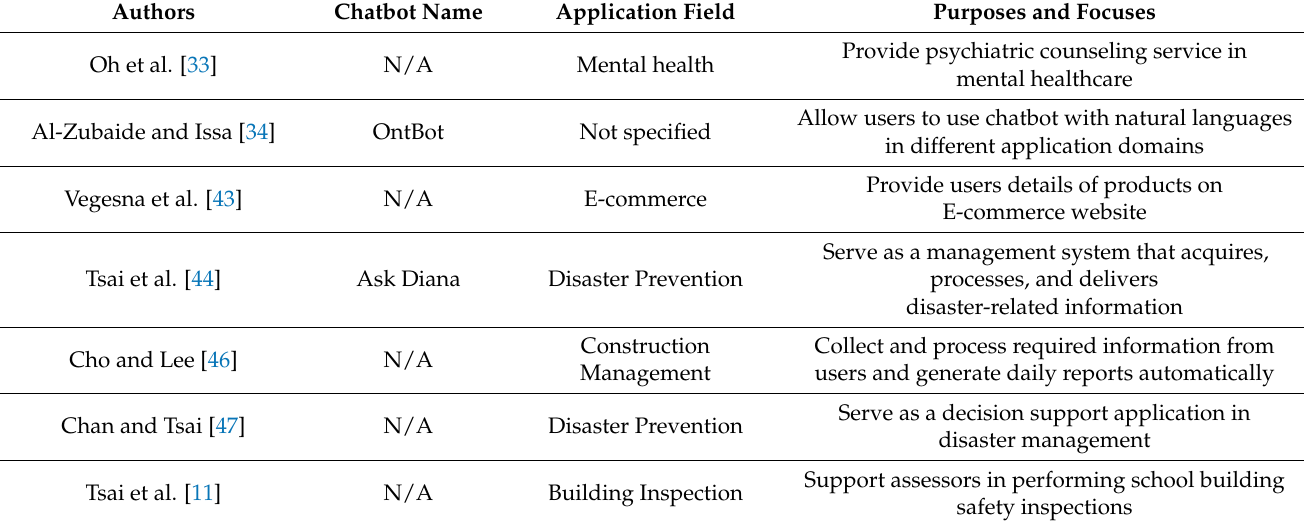
Table 1. Previous studies that developed chatbots for information